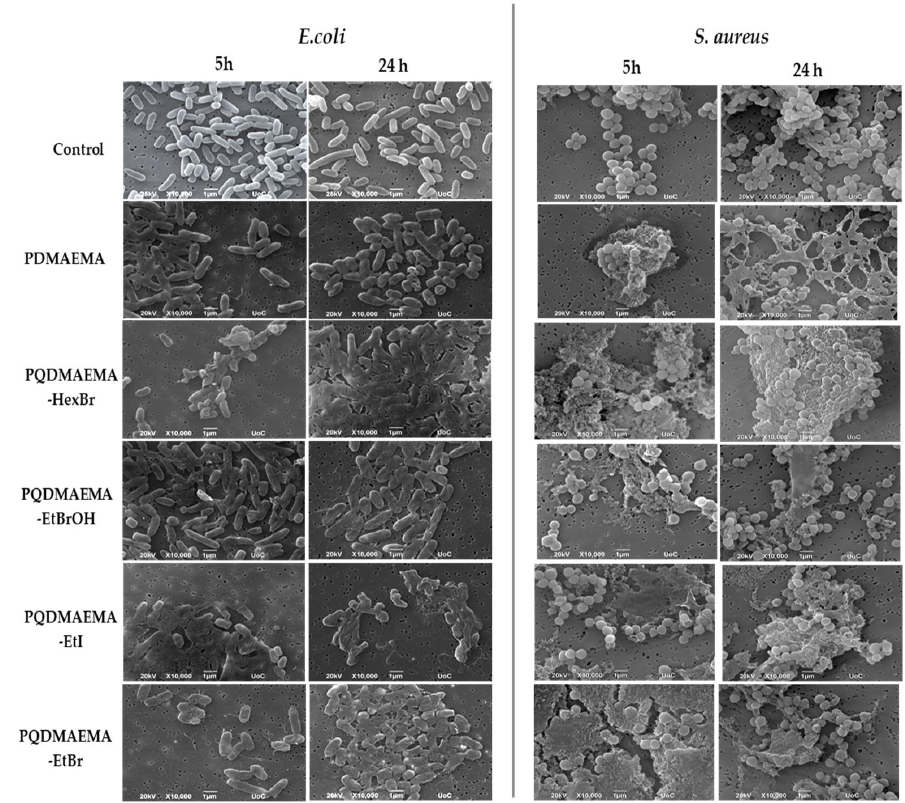
Figure 2. Representative scanning electron microscopy images of E. coli ( left ) and S. aureus ( right ) following incubation with 5 mg/mL cationic polymers for 5 and 24 h. The control represents the morphology of cells cultured in the absence of the polymers. Magnification is 10,000× and the scale bars represent 1 μ m.